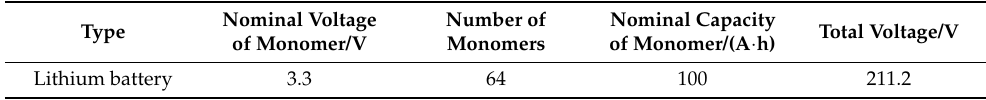
Table 2. Related parameters of power battery.